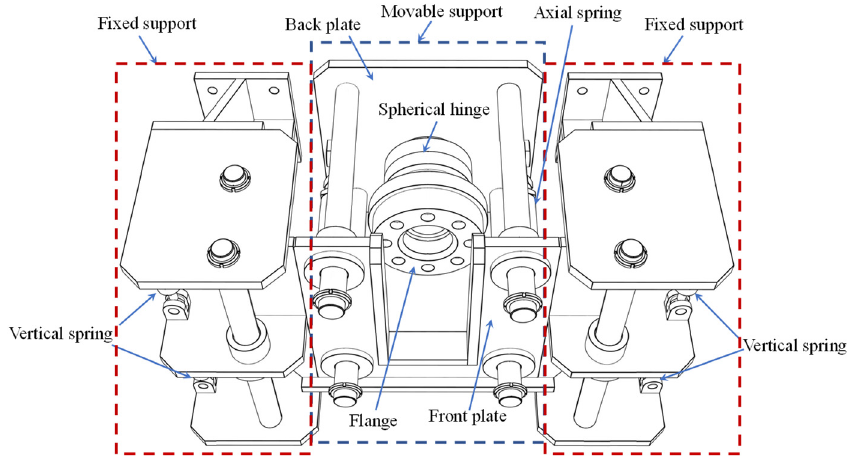
Figure 12. Schematic of the elastic support.